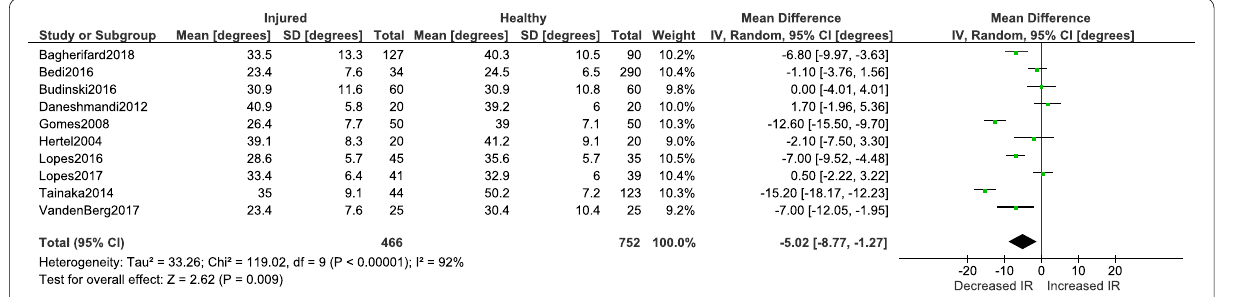
Fig. 2 Meta-analysis results detailing the association between passive internal rotation ROM and ACL injury